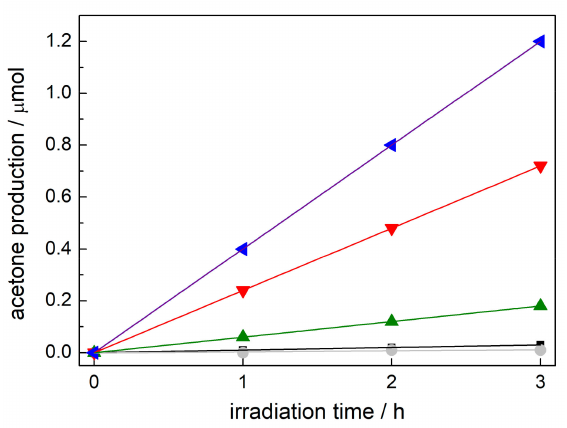
Figure 6. Visible light-induced ( λ > 455 nm) 2-propanol oxidation in the presence of ( (cid:4) ) TiO 2 , ( • ) Cu 2 O, ( (cid:78) ) Cu 2 O/TiO 2 , ( (cid:72) ) PTr-TiO 2 , and ( (cid:74) ) Cu 2 O/PTr-TiO 2 .